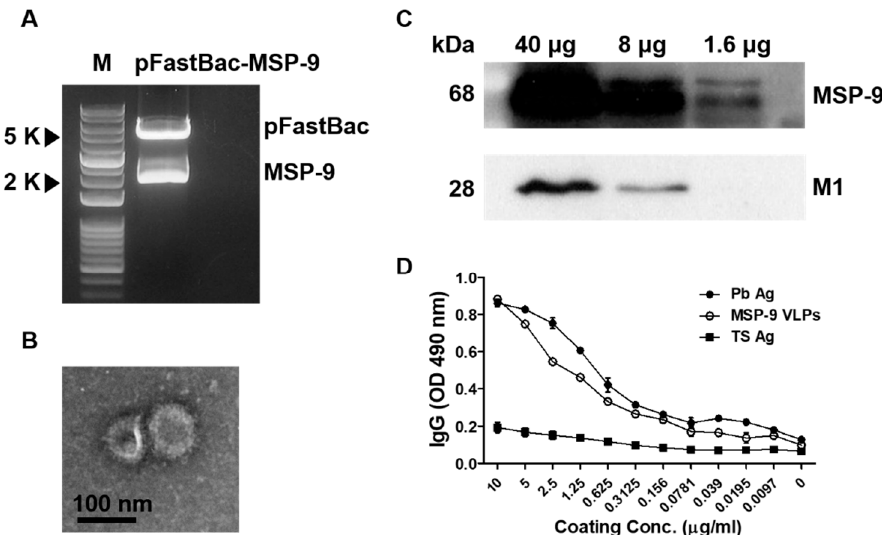
Figure 1. Recombinant plasmid pFastBac ‐ MSP ‐ 9 digestion and characterization of MSP ‐ 9 VLPs. The pFastBac ‐ MSP ‐ 9 plasmid was obtained by cloning the P. berghei optimized MSP ‐ 9 gene into a pFastBac